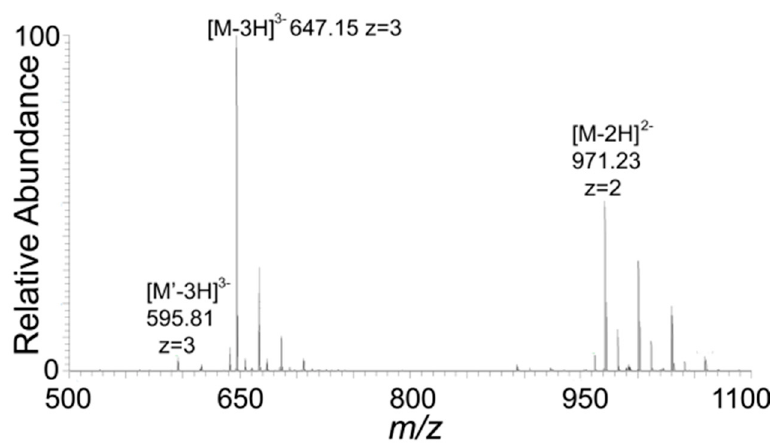
Figure 3. MS spectrum of resistant fraction 1. The spectrum matches that of a major component Δ UA-Kdo 7 -PG (M) and a very minor component Δ UA-Kdo 7 -glycerol (M’).